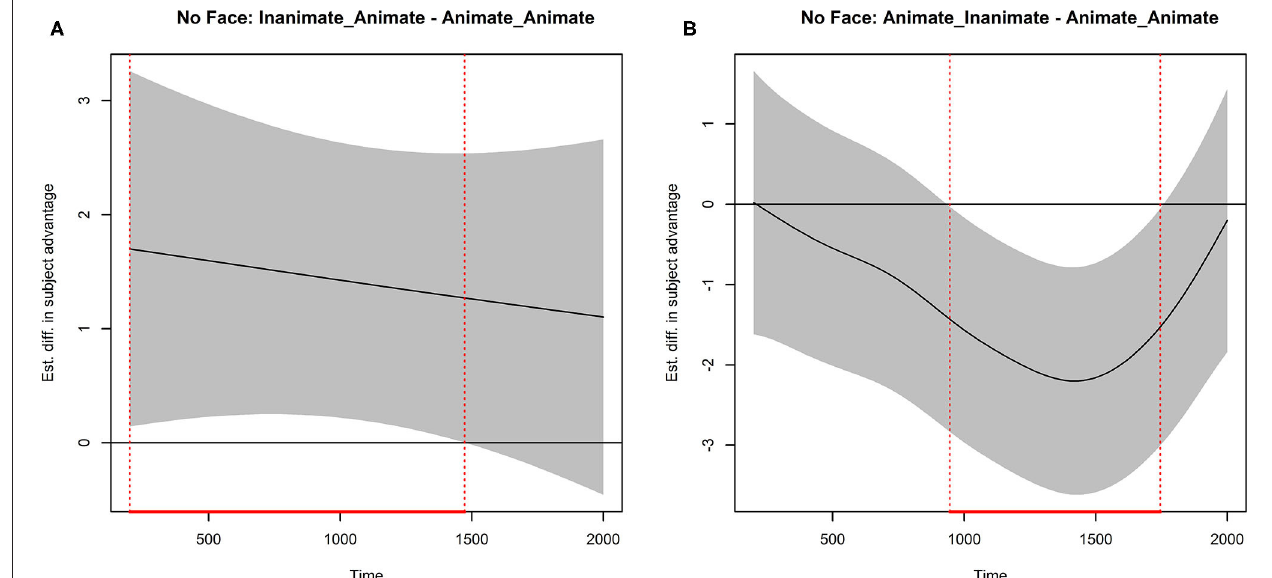
FIGURE 4 | Child data sentence type difference curves calculated from model-predicted curves with 99% confidence bands. Vertical lines indicate time points for which zero is not included in the confidence bands. (A) Inanimate-animate minus animate-animate (NoFace conditions). (B) Animate-inanimate minus animate-animate (NoFace